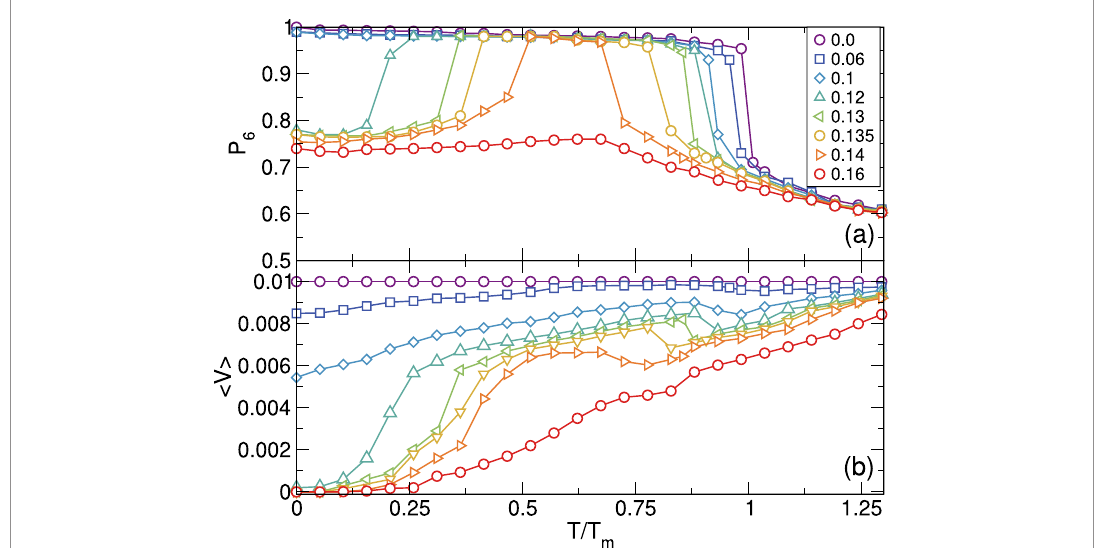
Figure 4. (a) P 6 vs T / T m for the system in figure 2 with n p = 0 . 25 at σ = 0.0, 0.06, 0.1, 0.12, 0.13, 0.135, 0.14, and 0.16, from top to bottom. For σ = 0.0, 0.06, and 0.1, there is no reentrant ordering, but for σ = 0.12, 0.13, 0.135, and 0.14, there is reentrant ordering with increasing temperature. (b) The corresponding velocity ⟨ V ⟩ vs T / T m at F D = 0 . 01. The velocities are low in the disordered regime at lower T / T m , but increase at the reentrant ordering transition. In addition, at the thermal melting transition there is a drop in ⟨ V ⟩ similar to the peak effect phenomenon found for superconducting vortices.